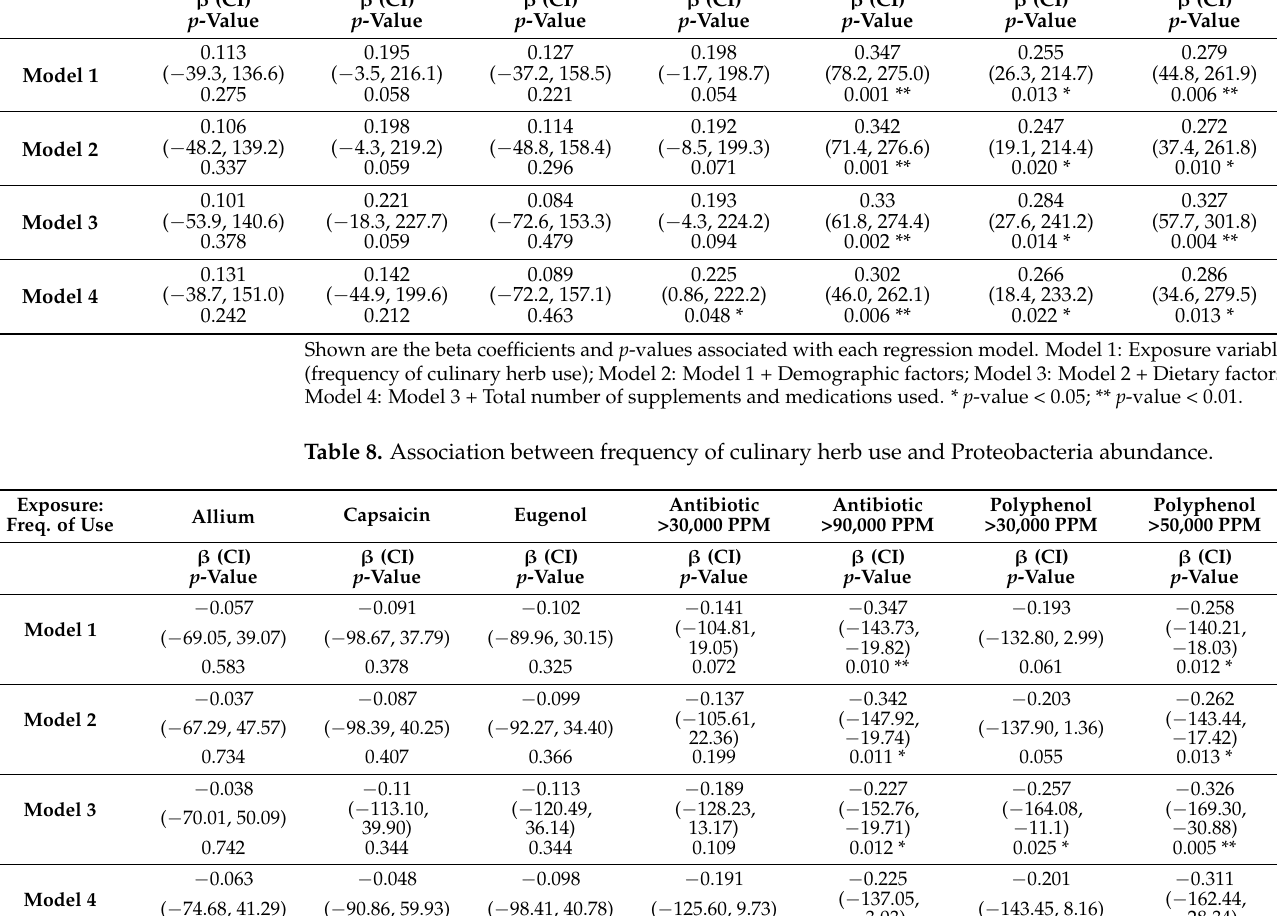
Shown are the beta coefficients and p -values associated with each regression model. Model 1: Exposure variable (frequency of culinary herb use); Model 2: Model 1 + Demographic factors; Model 3: Model 2 + Dietary